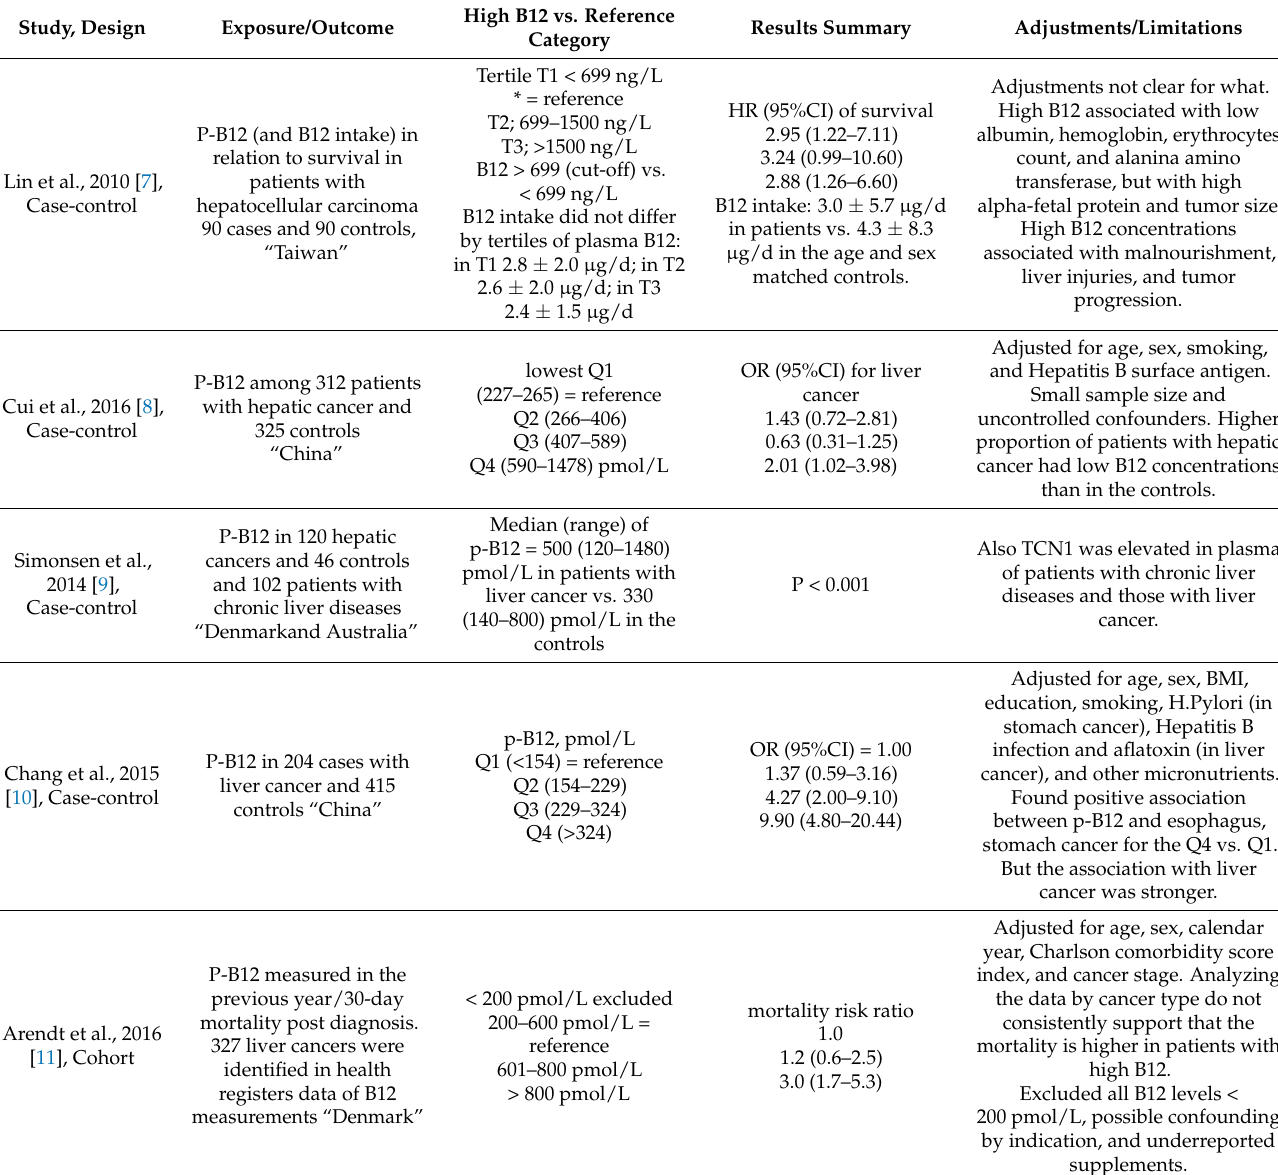
Table 1. Observational studies on plasma/serum vitamin B12 concentrations (p-B12 or s-B12) or B12 intake and liver